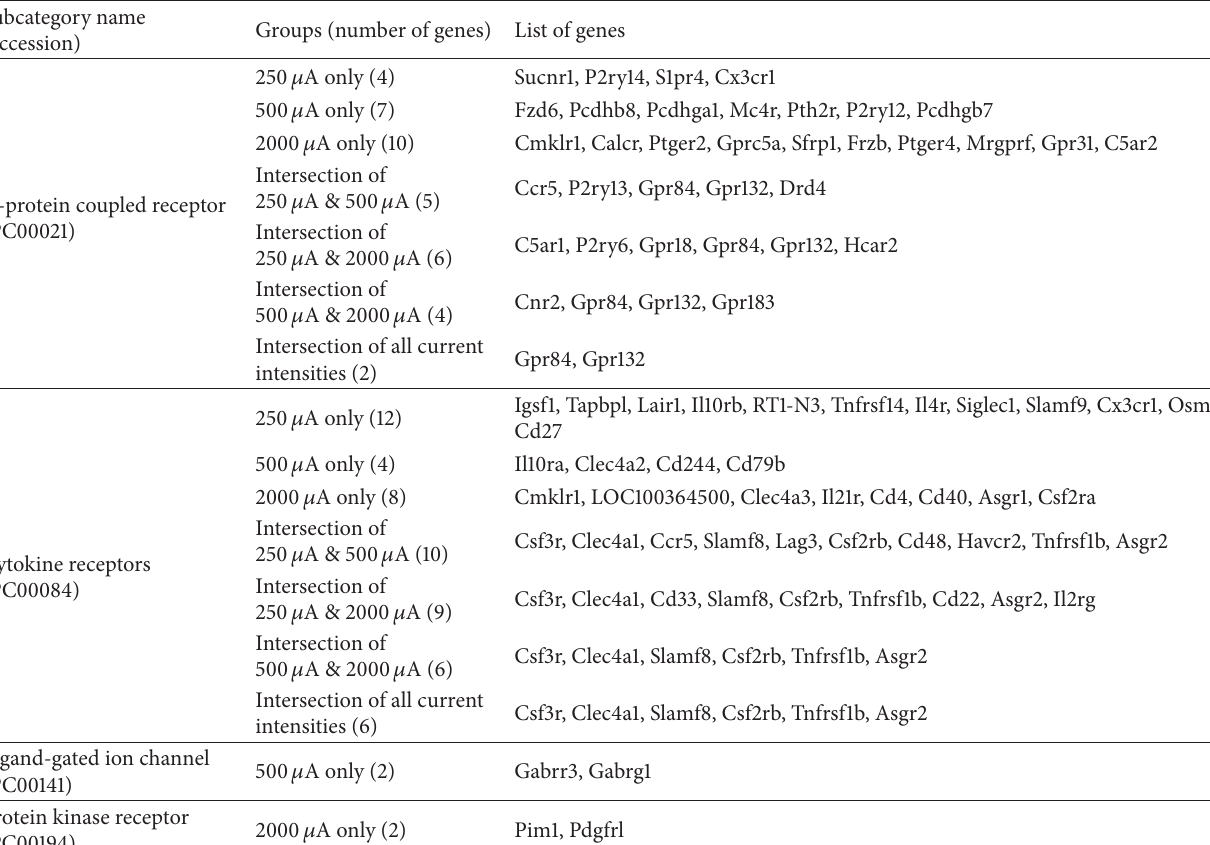
Table 3: Genes in the receptor subcategory that were detected from RNA-Seq data